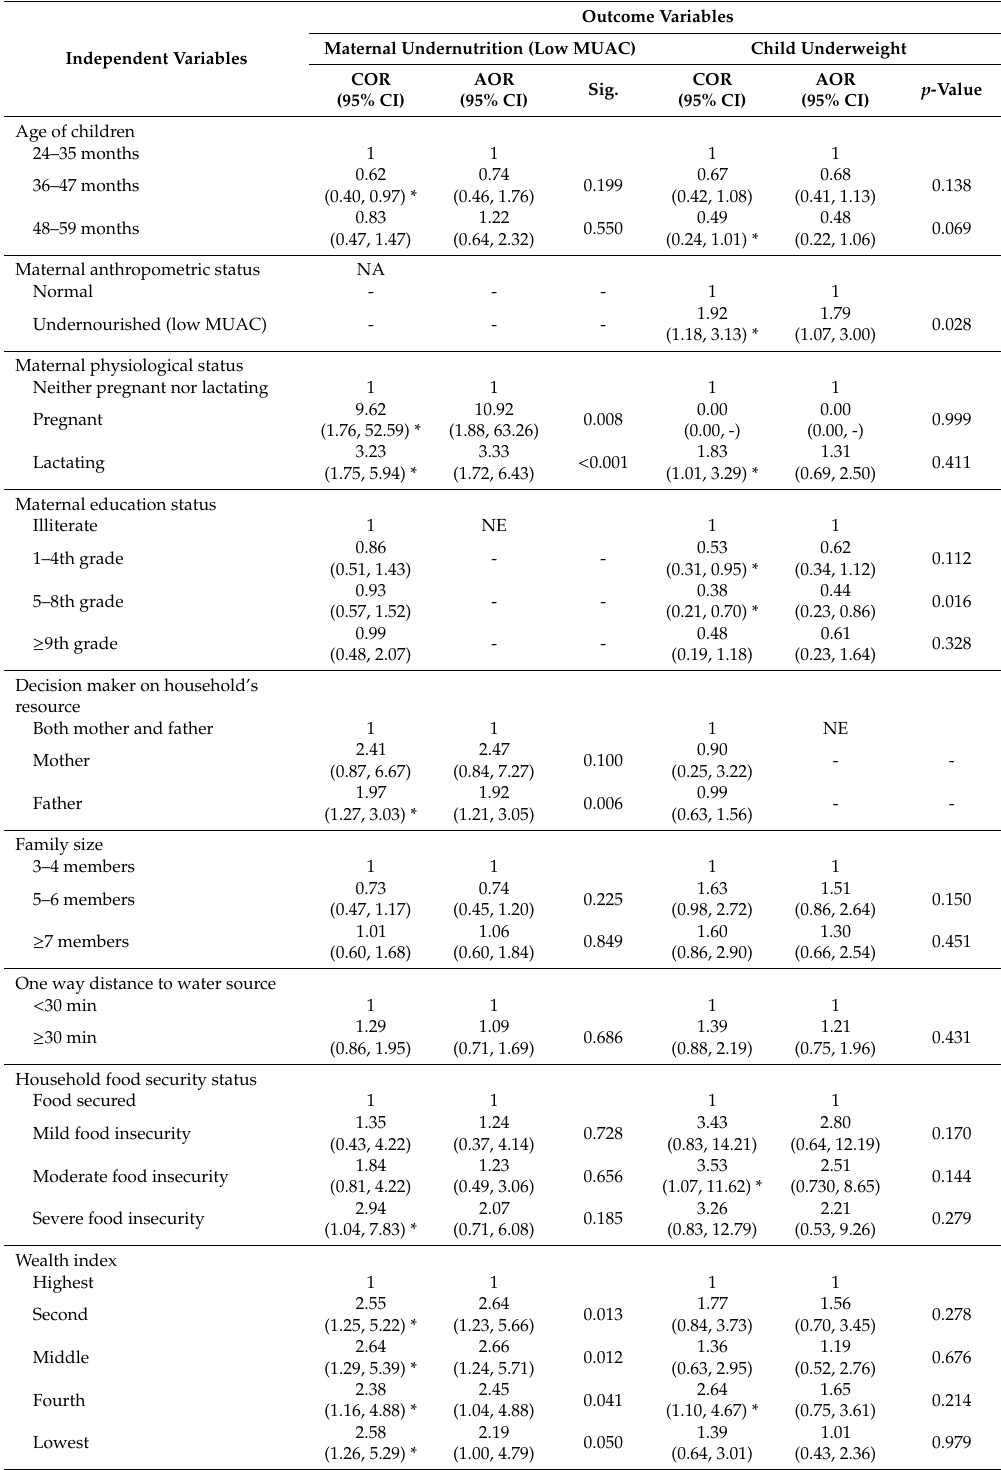
Table 6. Association of socioeconomic and dietary intake related variables with anthropometric status of MCP (N =